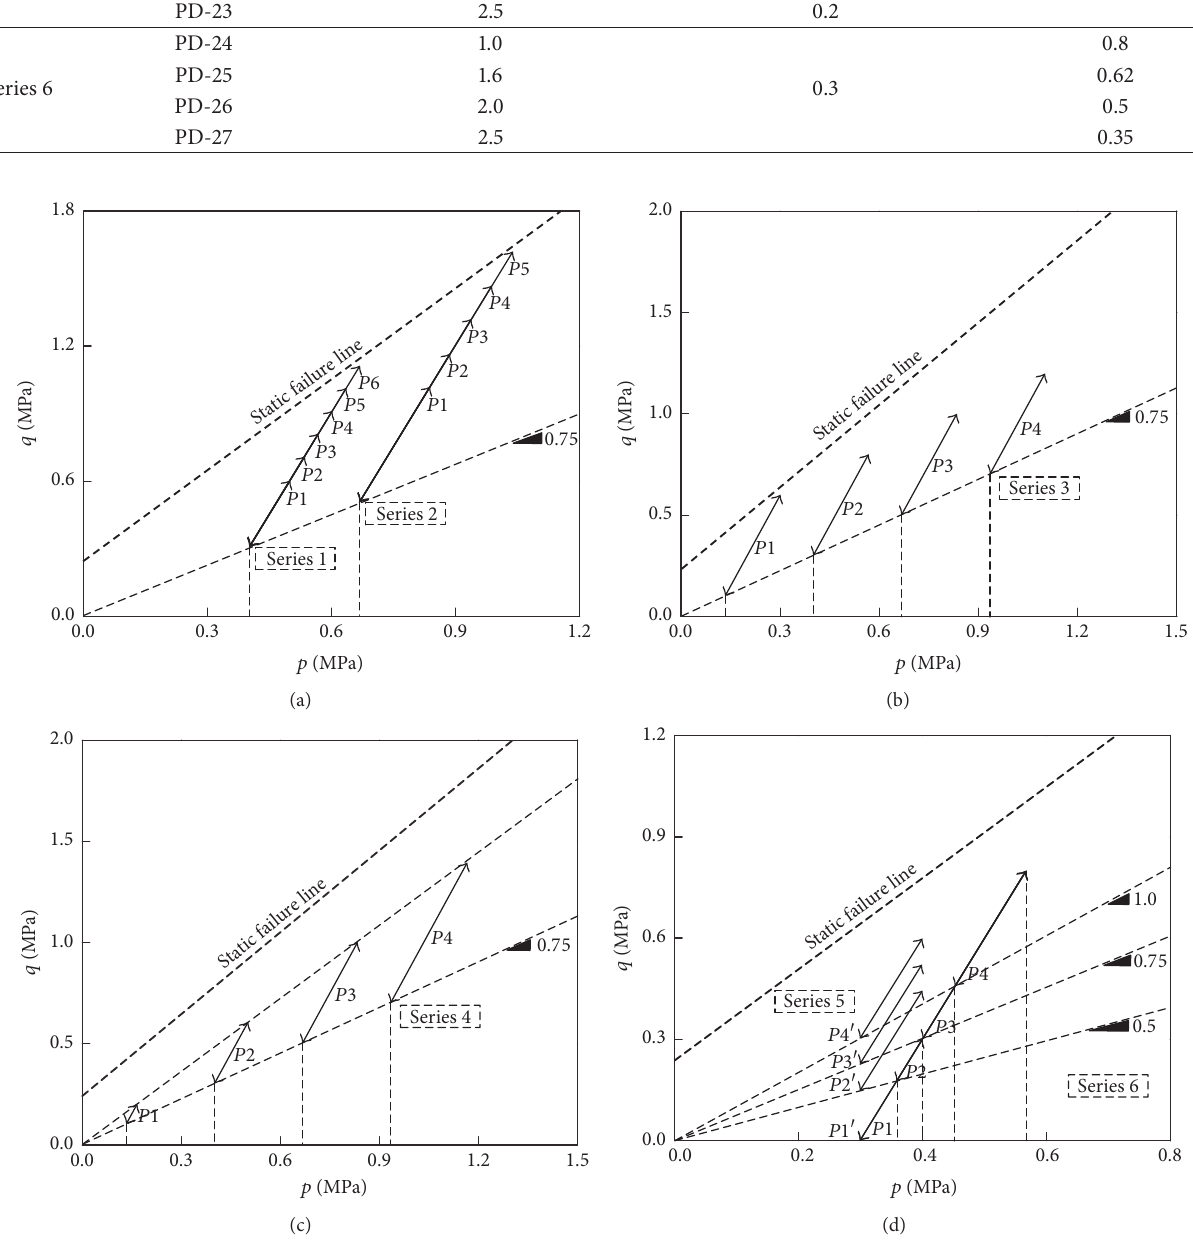
Figure 5: The applied stress paths in all six series of repeated load triaxial